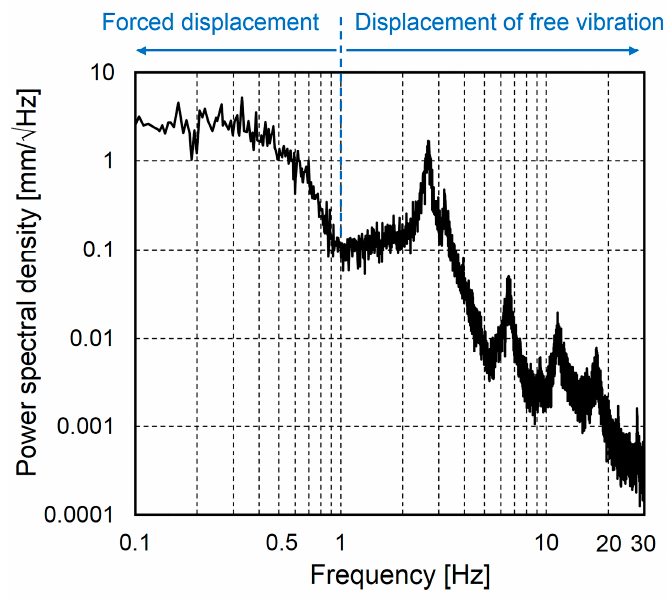
Figure 7. Displacement response spectrum at the longitudinal center of the lower flange of the main girder.